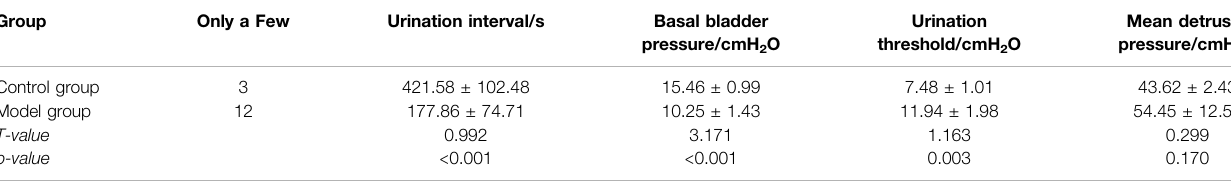
TABLE 2 | Cell proliferation (S) was detected by MTT assay.